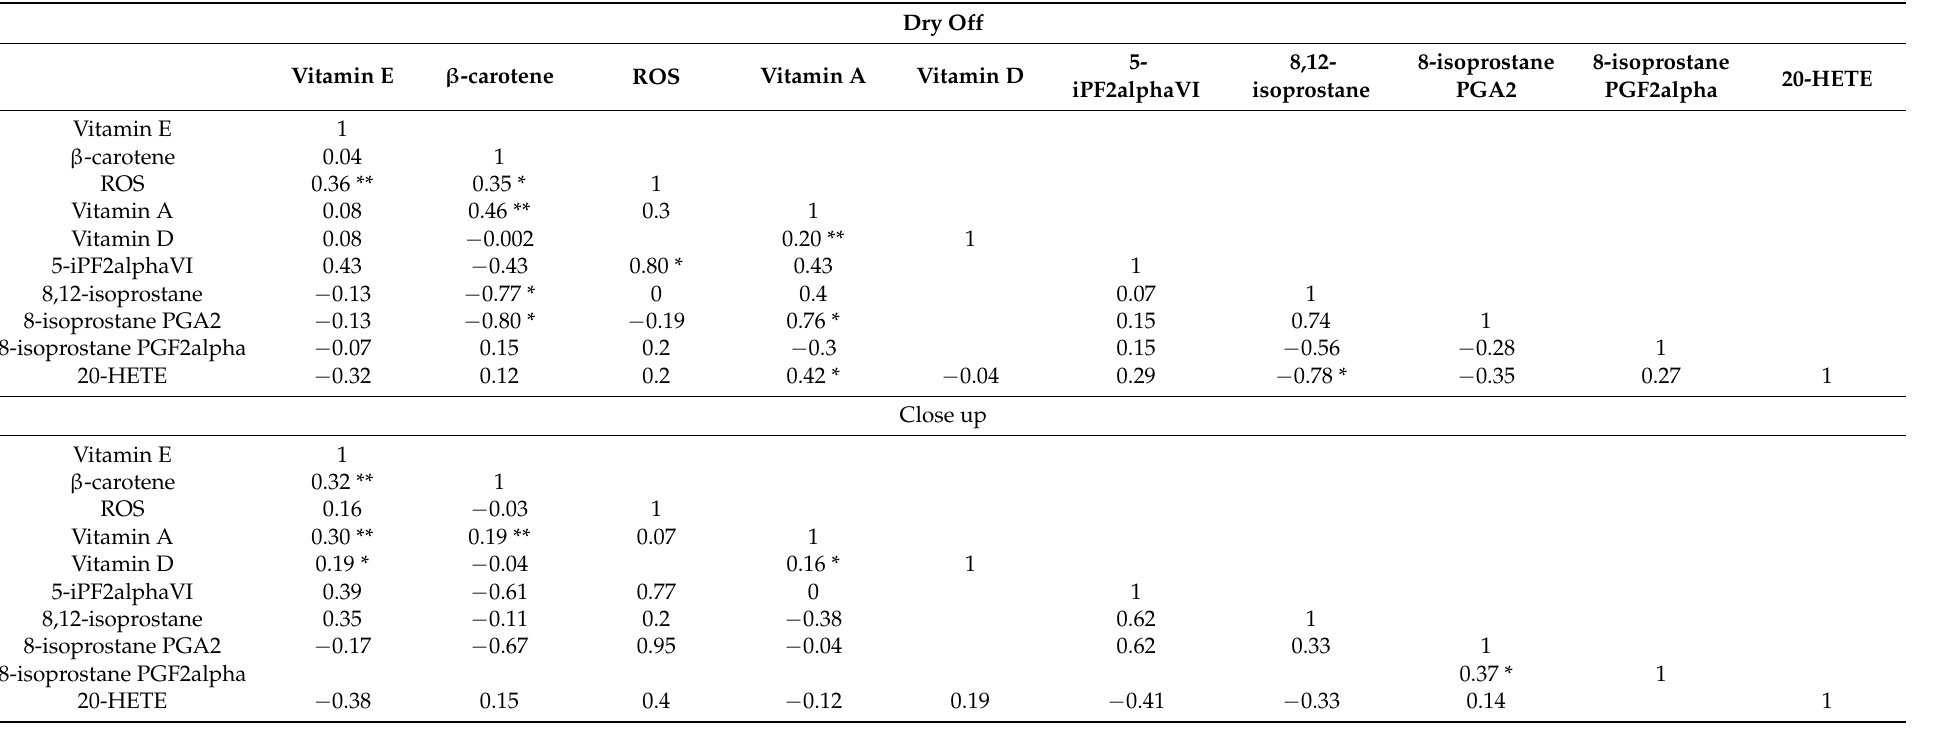
Table 3. Correlation analysis results for vitamins, oxylipids. 20-HETE, and